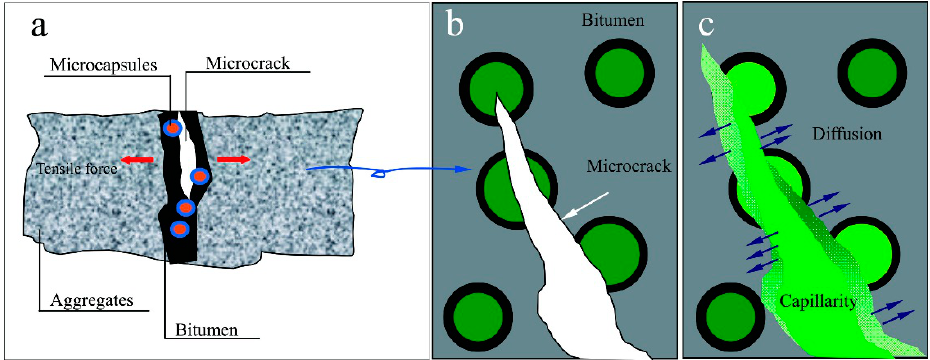
Figure 1. Illustration of the self-healing process of aged bitumen by microcapsules containing rejuvenator: ( a ) the structure of asphalt consisting of bitumen and aggregates; ( b ) microcrack generation and microcapsules broken; and ( c ) the self-healing of aged bitumen by leaked rejuvenator with the help of diffusion and capillarity actions.